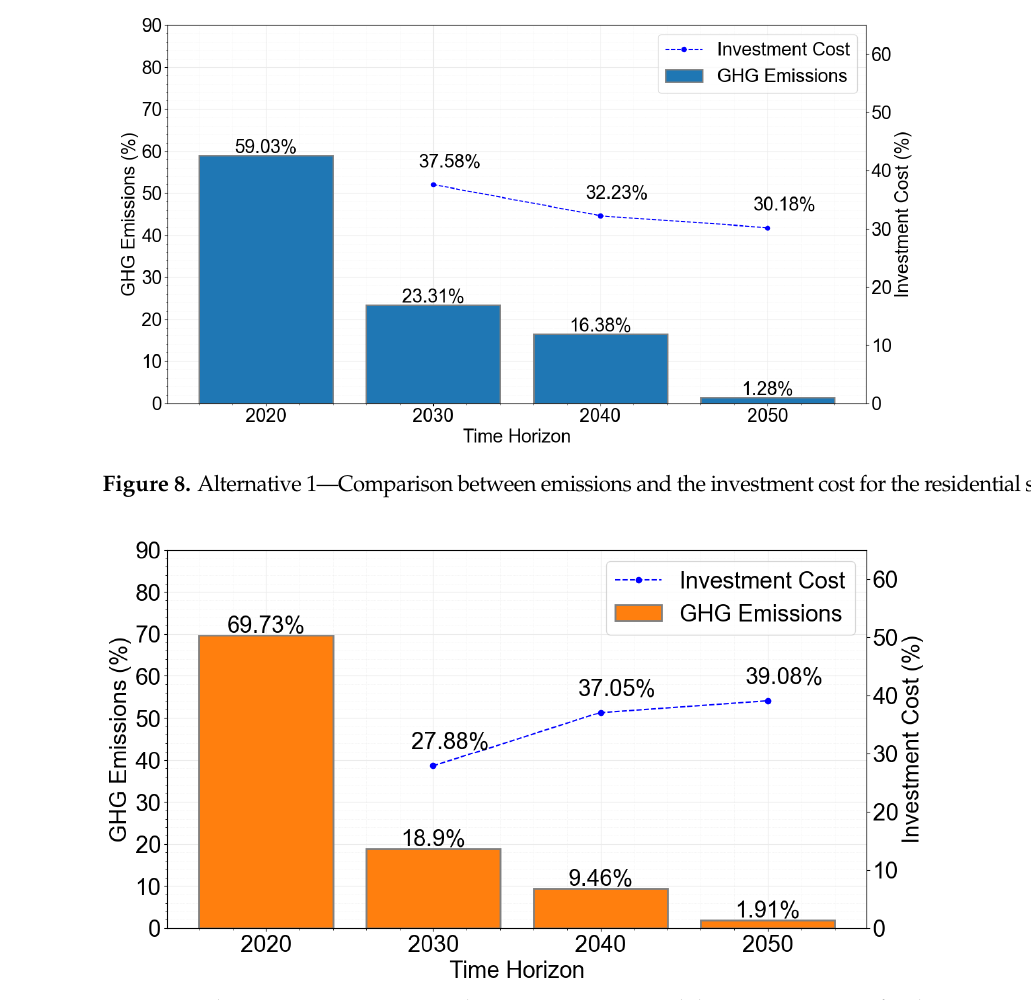
Figure 9. Alternative 1—Comparison between emissions and the investment cost for the service